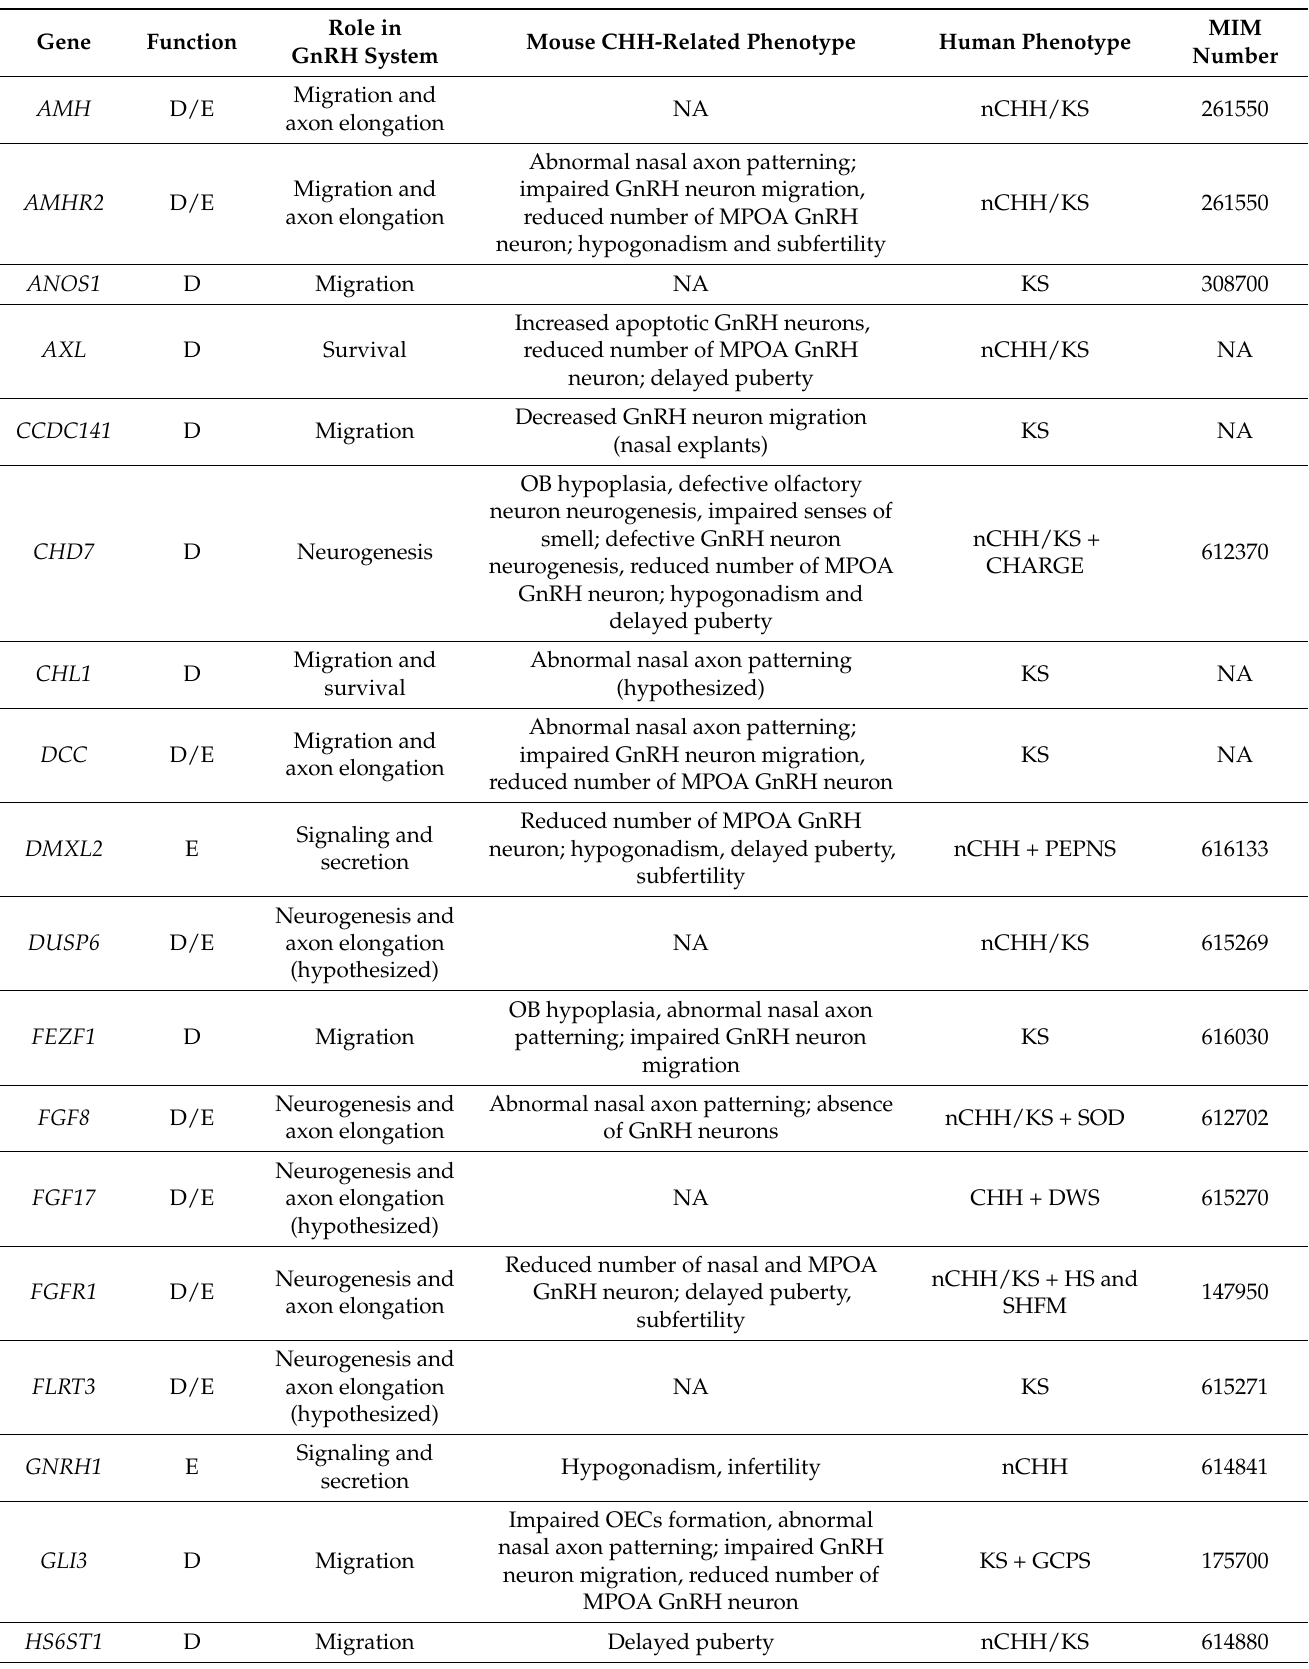
Table 1. List of known CHH-associated